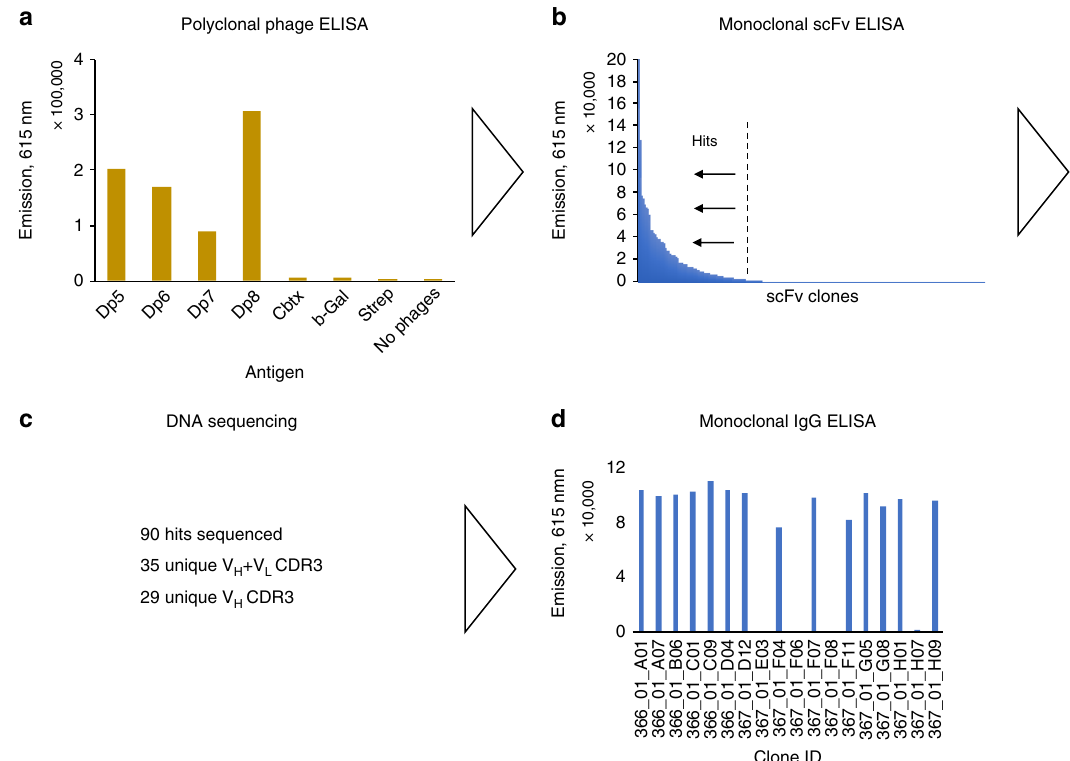
Fig. 2 Schematic overview of selected results from the employed discovery process. Here, demonstrated for human IgGs against the antigen, Dp8. a Polyclonal phage ELISA signals against different venom fractions and negative control antigens (Cbtx α -cobratoxin, b-Gal β -galactosidase, Strep Streptavidin). b Monoclonal scFv ELISA signals against Dp8. c Summary of DNA sequencing results. Sequences are de fi ned as unique based on V H and V L CDR3 sequences. d Monoclonal IgG ELISA signals for converted clones demonstrating retained binding for the majority of the clones upon conversion from the scFv format